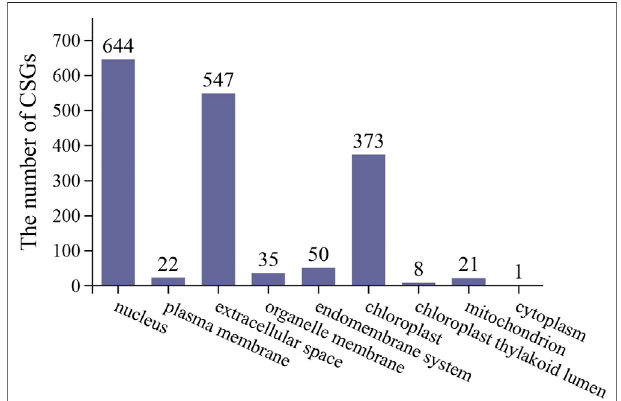
FIGURE 5 | Camellia -speci fi c genes assigned to different subcellular locations.